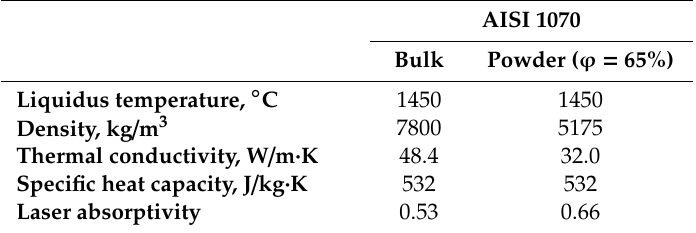
Table1. PhysicalpropertiesoftheAISI1070bulkandpowderedalloys[14]usedforthemeltpoolmodeling.